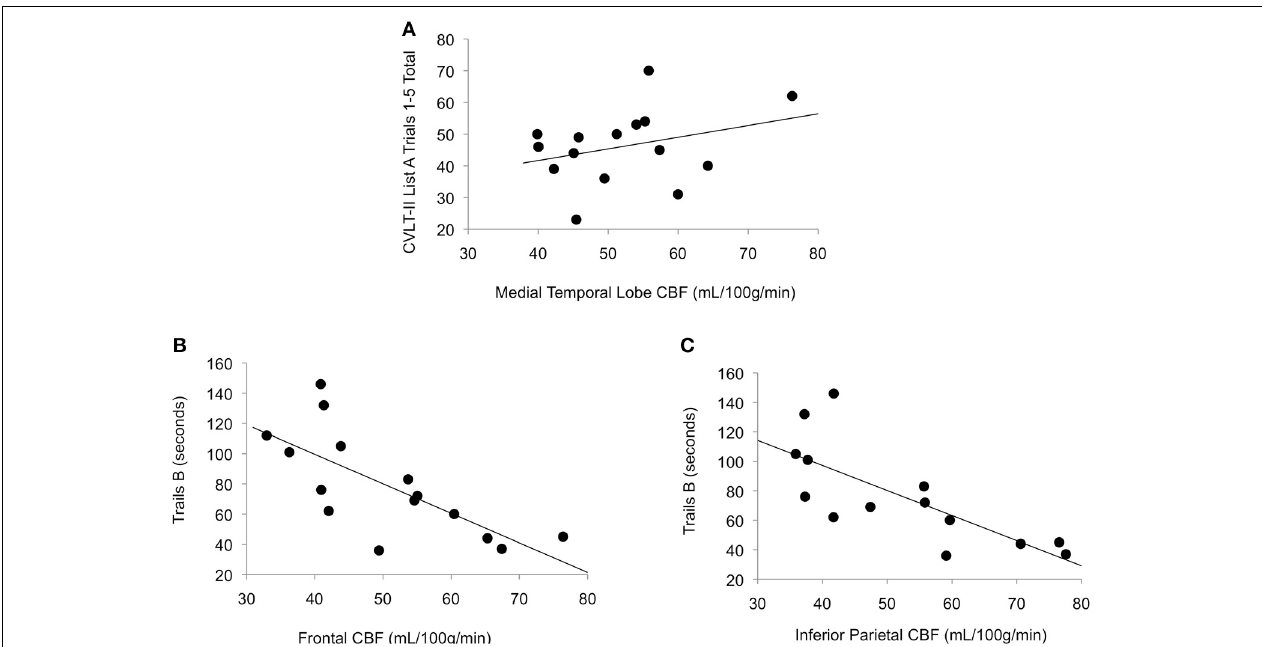
FIGURE 2 | Scatterplots of correlations between cerebral blood flow and cognitive performance for older adults with elevated vascular risk burden. (A) Correlation between memory performance and medial temporal lobe cerebral blood flow ( p = 0 . 13), (B) Correlation between executive